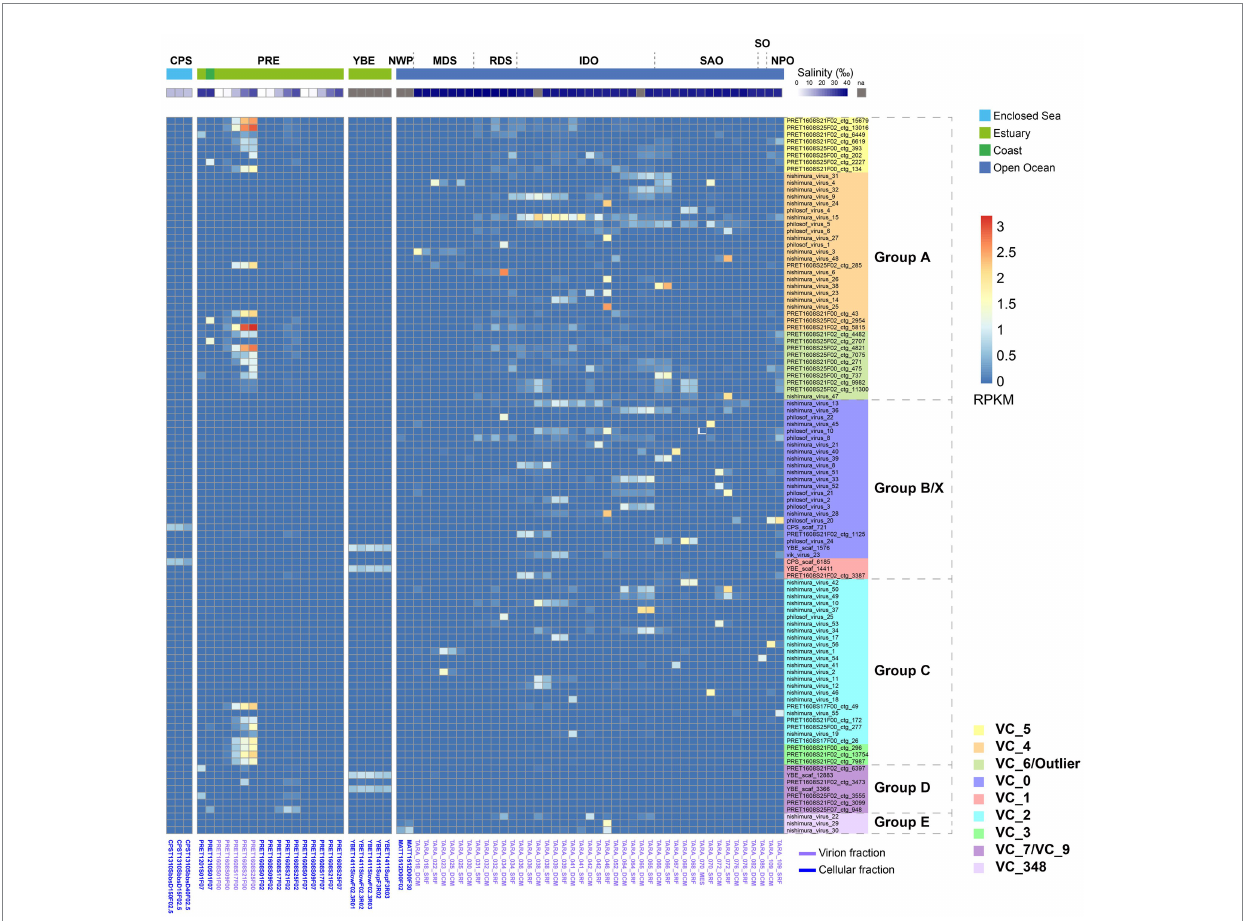
FIGURE 3 Global abundance and distribution of magroviruses. Heatmap shows the magroviral vOTUs with max RPKM value above 0.9. Abbreviations of sampling areas: CPS, Caspian Sea; PRE, Pearl River estuary; YBE, Yaquina Bay estuary; NWP, Northwest Pacific Ocean; MDS, Mediterranean Sea; RDS, Read Sea;